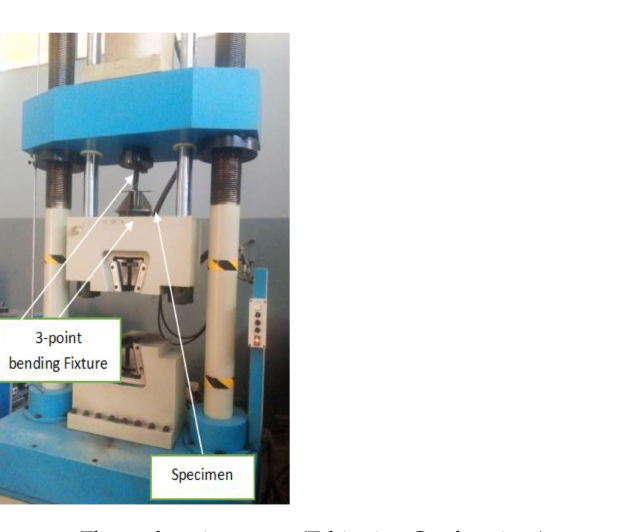
Figure 11. Flexural testing setup (Ethiopian Conformity Assessment Enterprise).